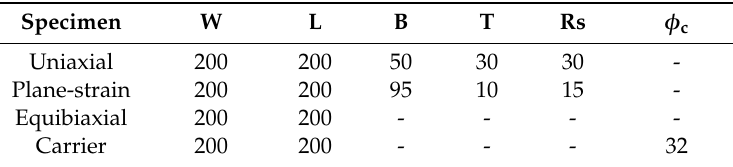
Table 4. Detailed dimensions for each FLC specimen in mm.